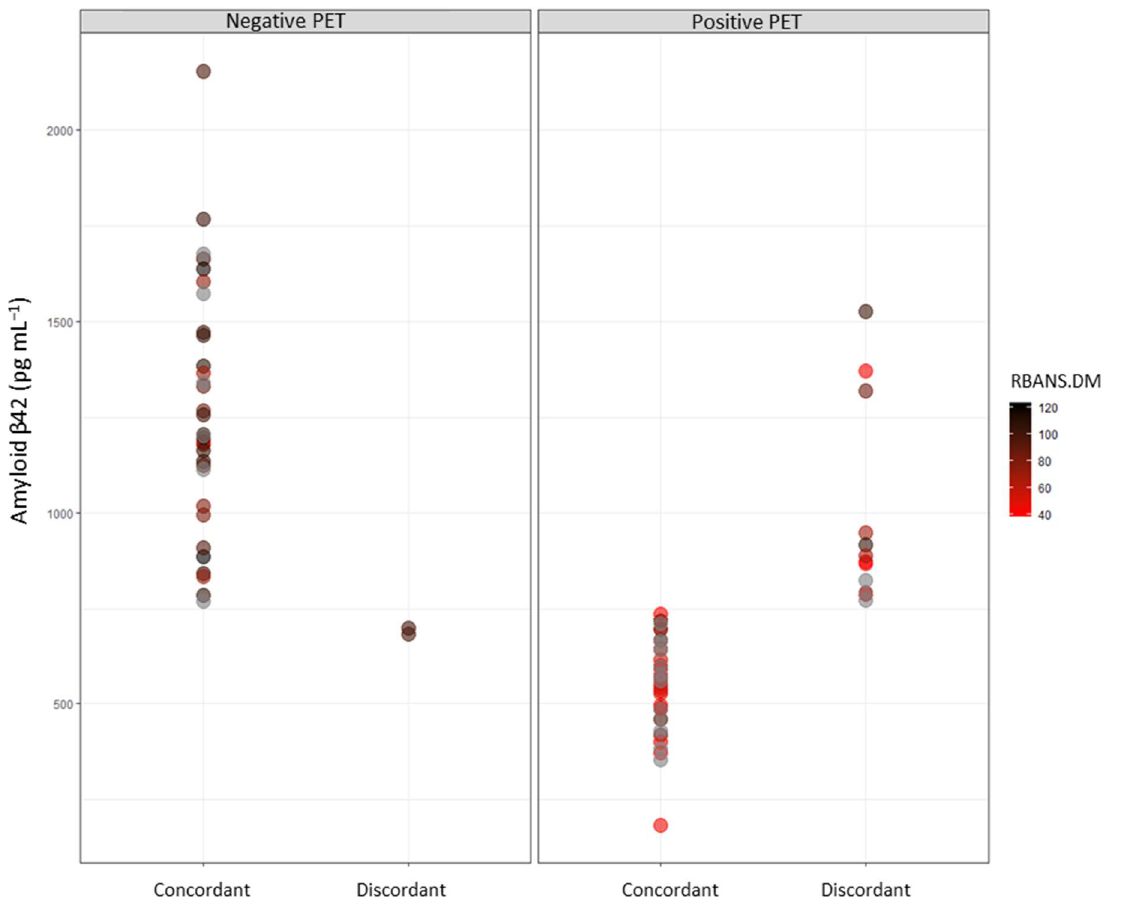
Figure 3. Relationship between A β 1-42 CSF and RBANS.DM levels depending on the amyloid PET result; negative PET on the left, positive PET on the right.